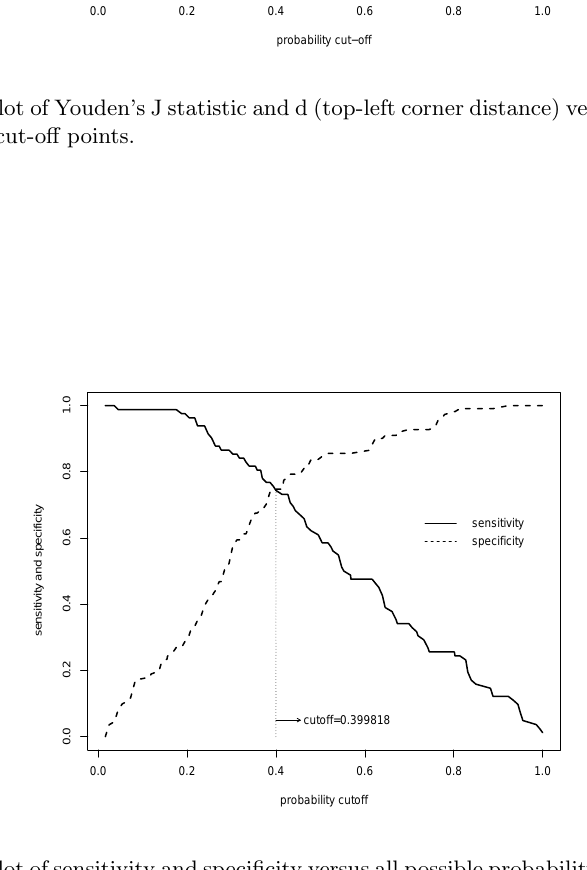
Figure 5 – Plot of sensitivity and specificity versus all possible probability cut-off